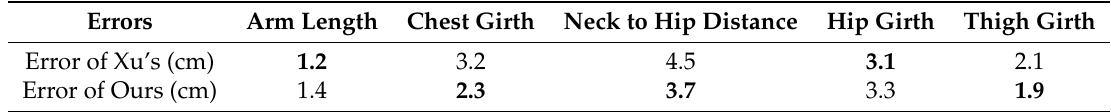
Table 2. Comparison of body parameters with Xu’s.